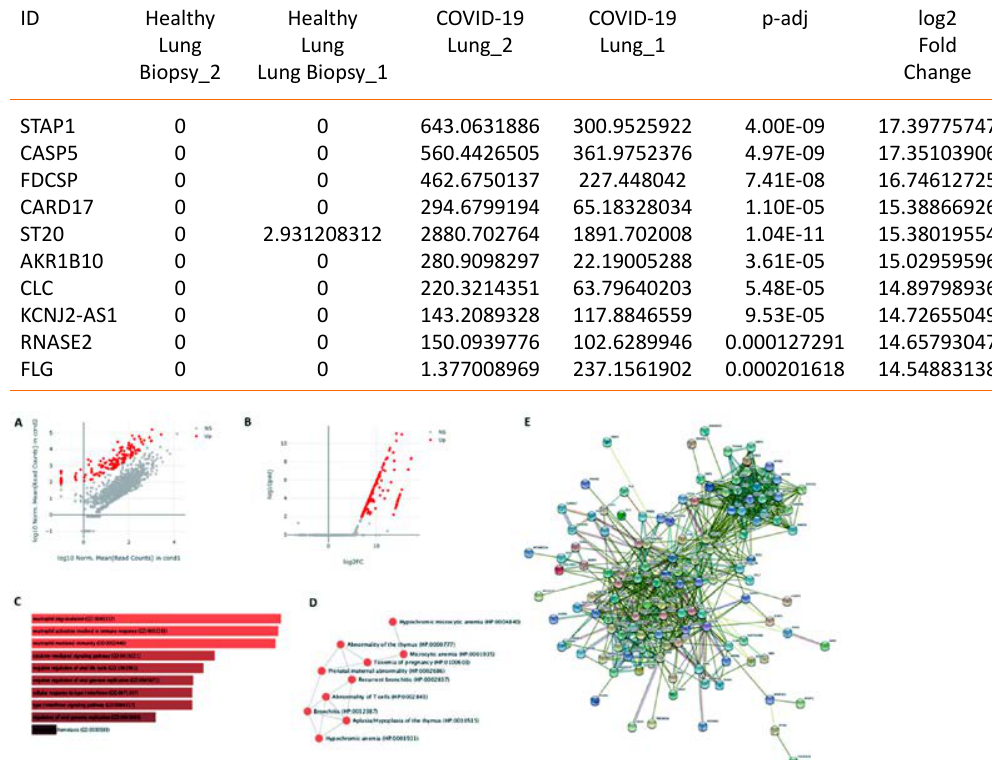
Table 1. Top ten screened significant DEGs in the decreasing order of their log2 Fold change